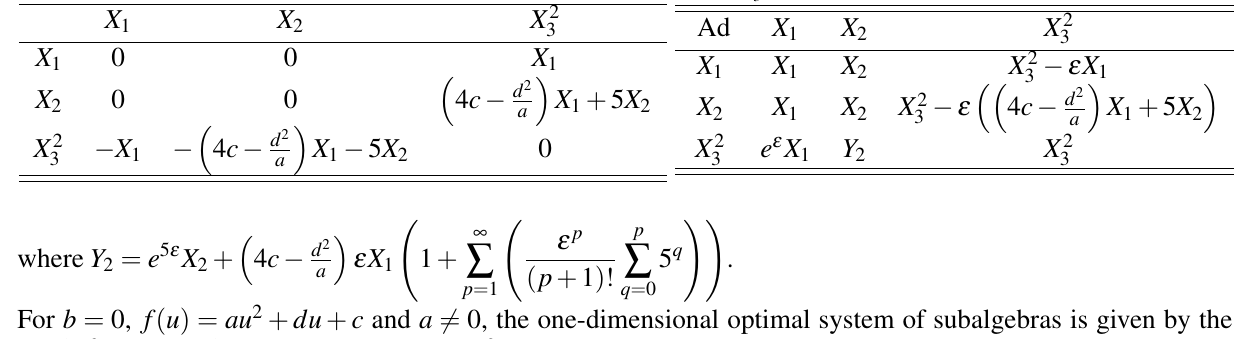
Table 4: Adjoint table for the Lie algebra { X 1 , X 2 , X 2 } . 3